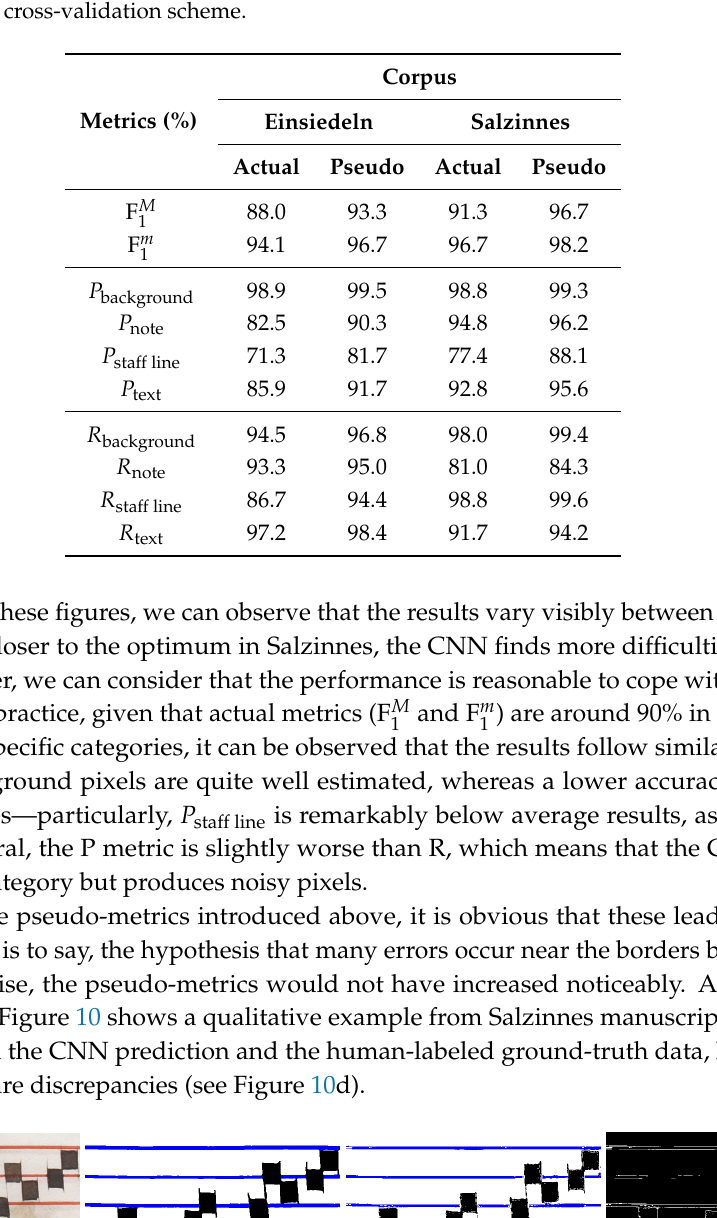
Table 5. Final results obtained by the best CNN configuration. Results reported represent averages from a five-fold cross-validation scheme.